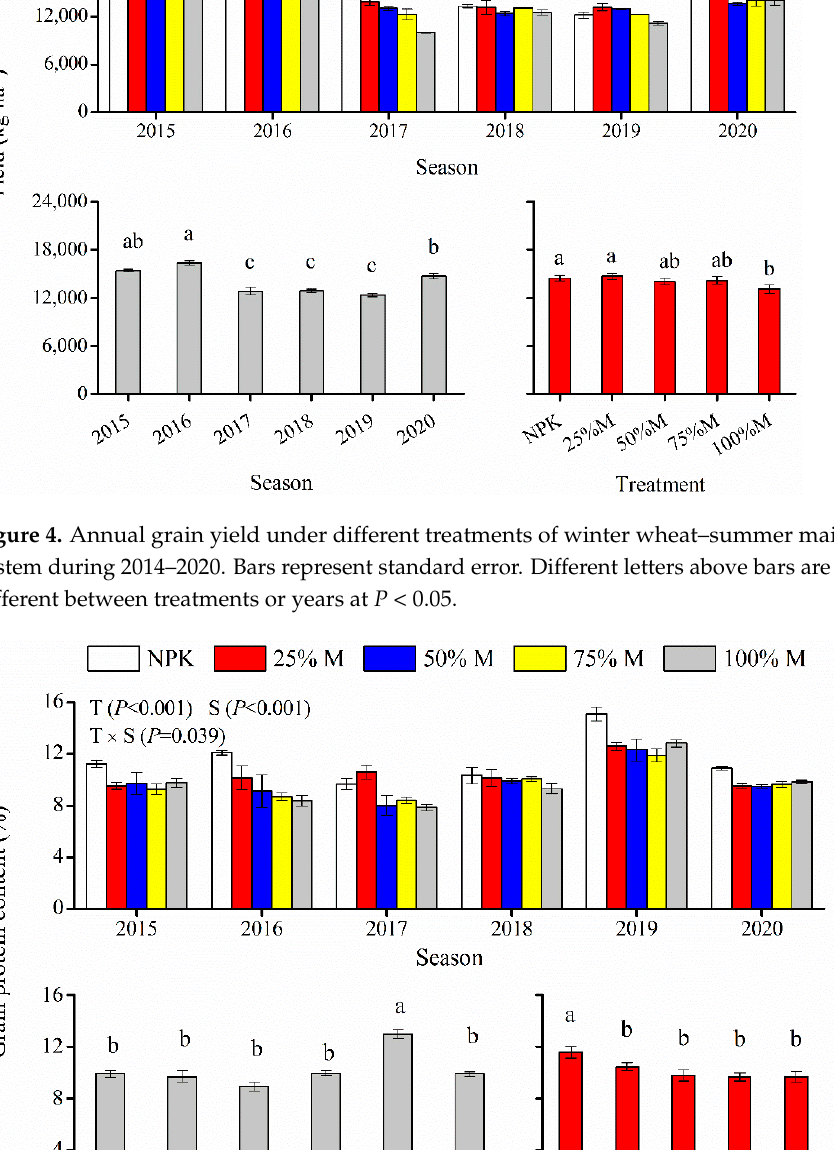
Figure 4. Annual grain yield under different treatments of winter wheat–summer maize cropping system during 2014–2020. Bars represent standard error. Different letters above bars are signifi- cantly different between treatments or years at P < 0.05.